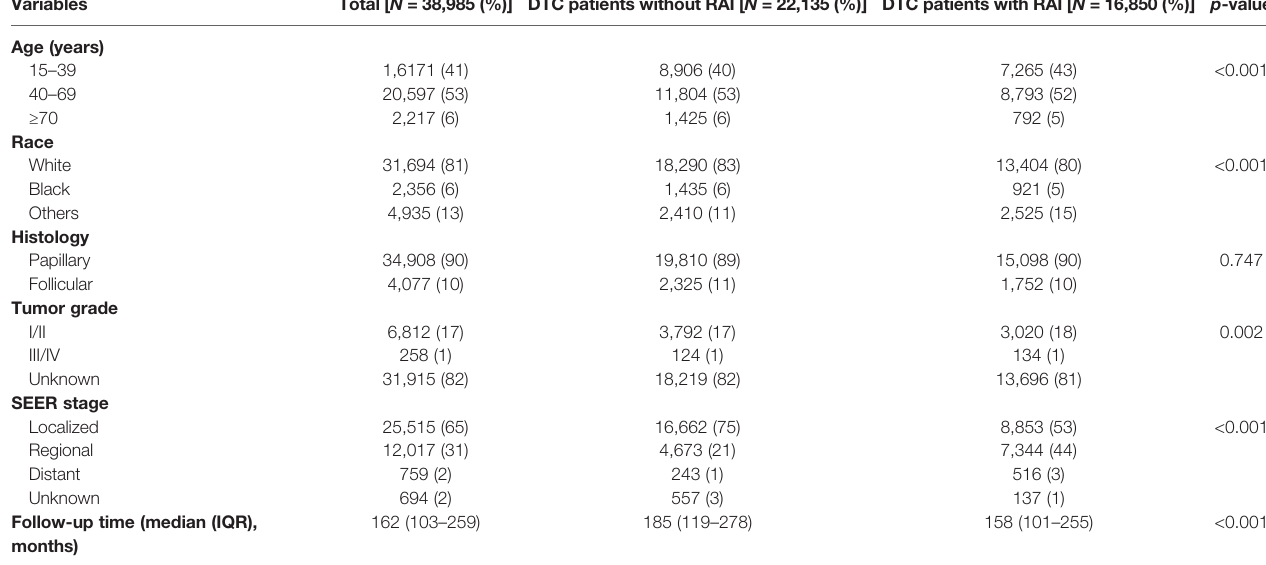
TABLE 1 | Baseline clinical feature comparison between differentiated thyroid cancer patients with and without radioiodine.